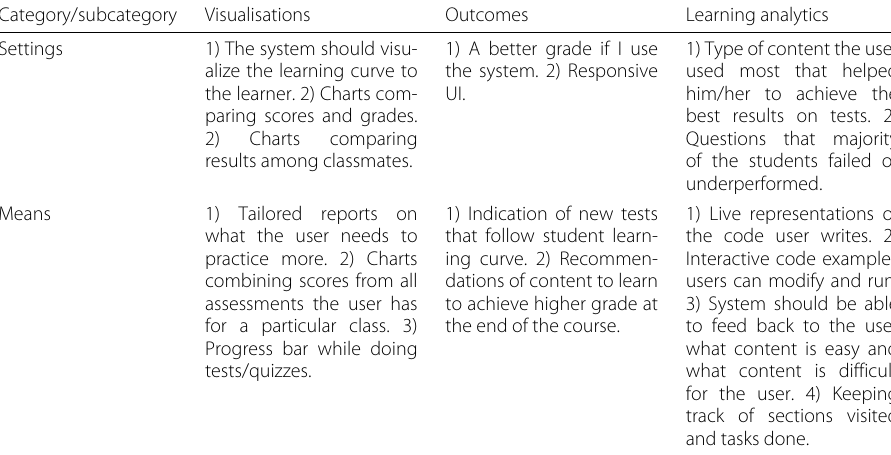
Table 2 Affinity diagram composition after interacting with ProTuS Category/subcategory Visualisations Outcomes Learning